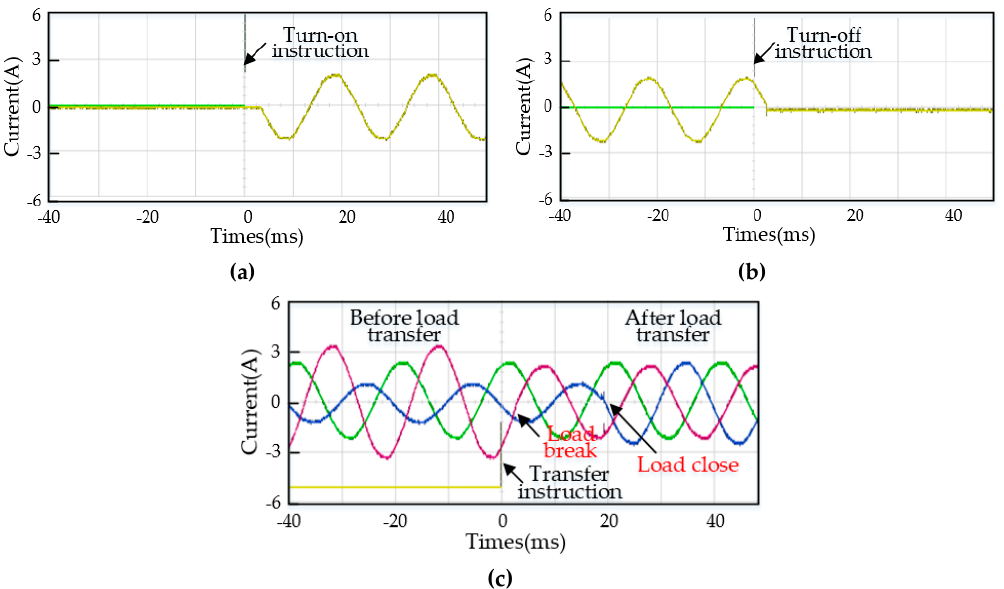
Figure 16. The current waveform of the switching action in the actual experiment. ( a ) Zero-current